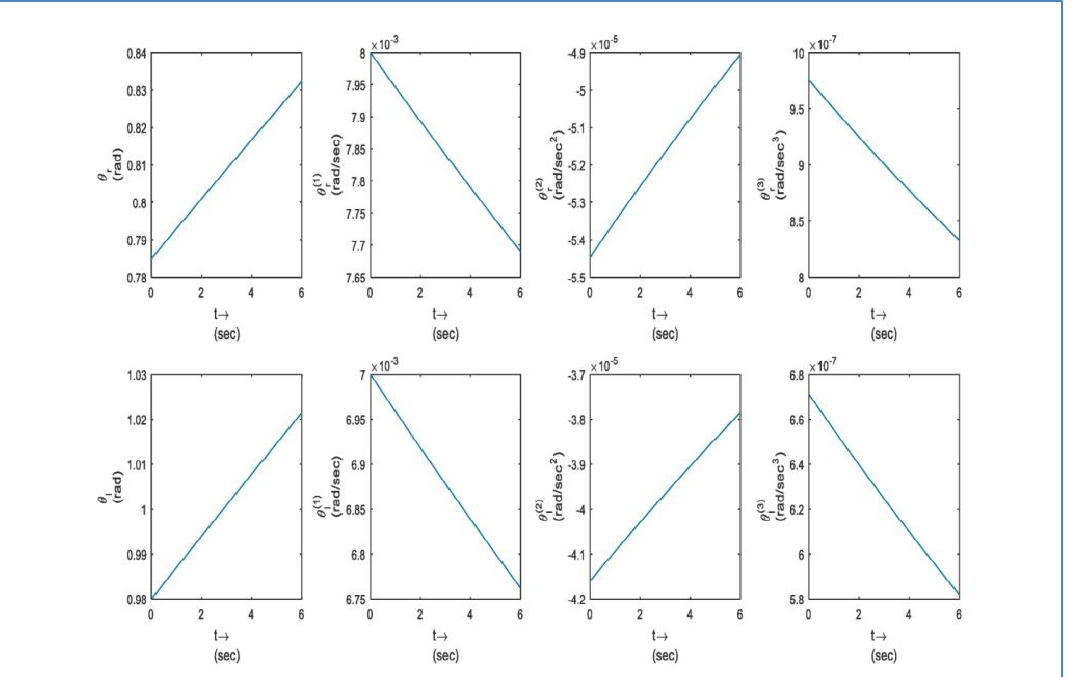
Figure 3. Trajectories of the wheel rotation angles and their derivatives